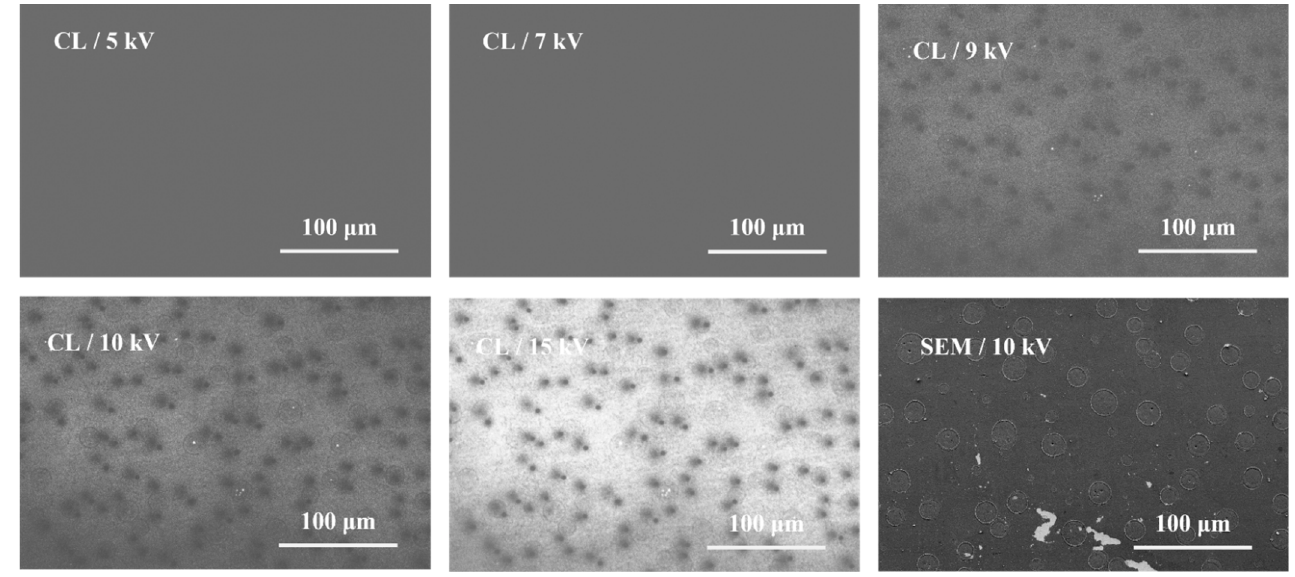
Figure 3. CL images of full-composition-graded In x Ga 1 − x N film excited with electron beams ranging from 5 kV to 15 kV at room temperature.